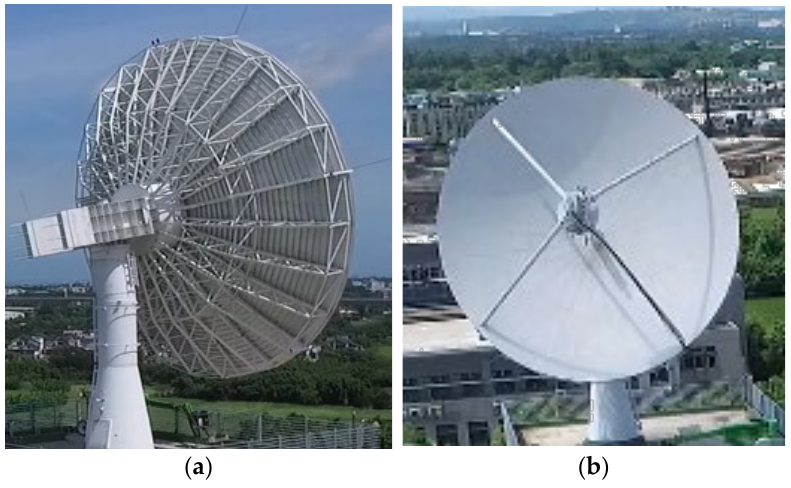
Figure 3. The antenna of CSRSR captured by UAV [72]. The back ( a ) and front ( b ) of the antenna.